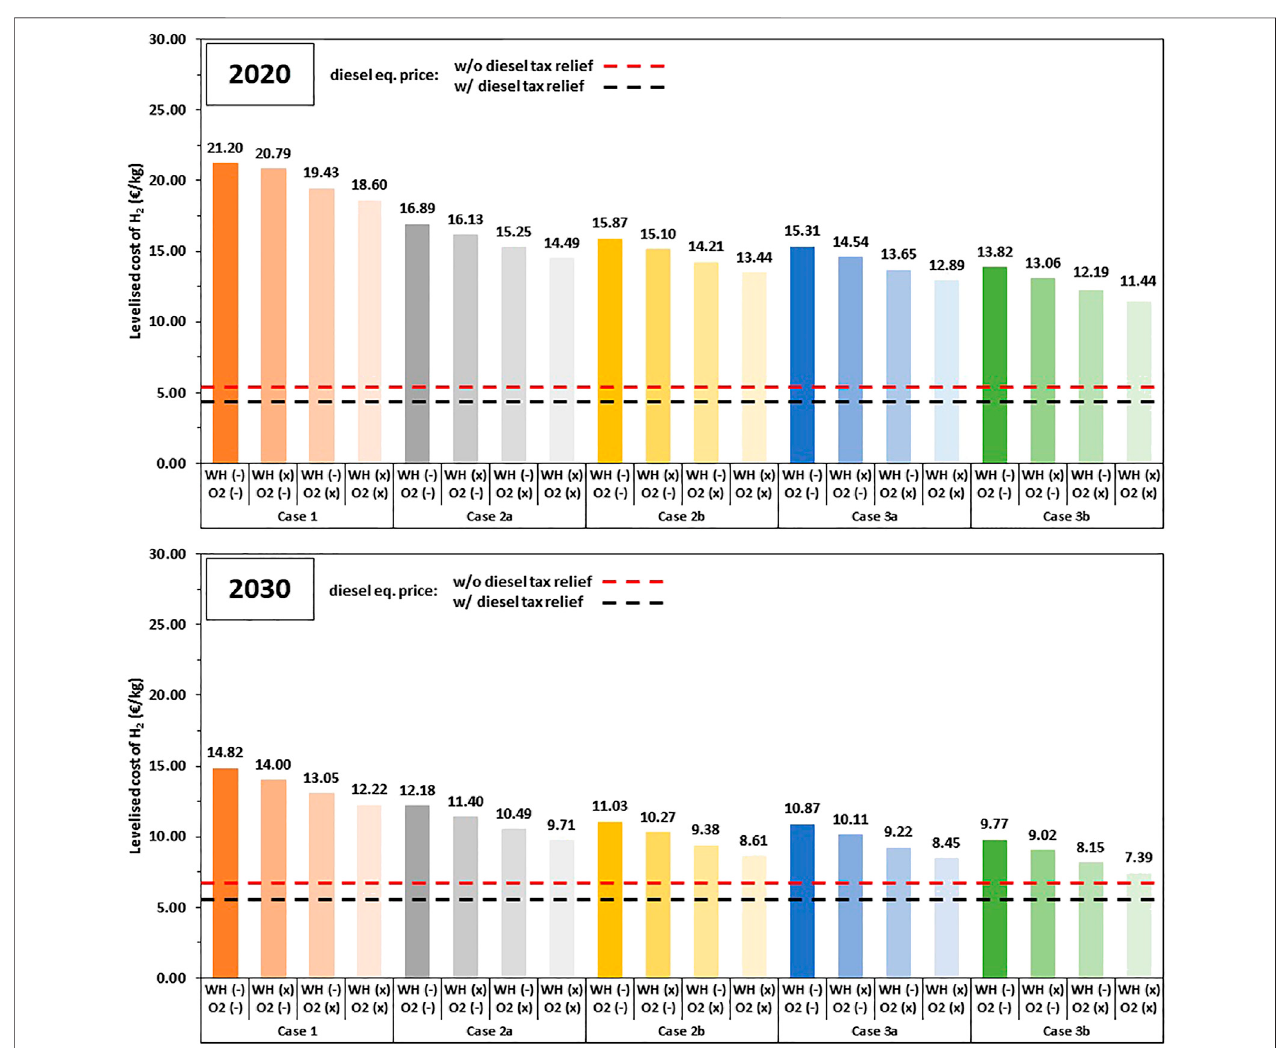
FIGURE 7 | Effect of by-products recovery on the levelized cost of H 2 (LCOH 2 ) according to the different cases assessed. Note: Red dotted lines represent the dieselequivalentpricewithouttaxrelief(2020 – 1.35 € /Lor5.33 € /kgH 2 ;2030 – 1.62 € /Lor6.40 € /kgH 2 );blackdottedlinesrepresentthedieselequivalentpricewithtax relief (2020 – 1.17 € /L or 4.62 € /kg H 2 ; 2030 – 1.40 € /L or 5.53 € /kg H 2 ); WH – waste heat; O 2 – oxygen; (-) without; and (x) with.